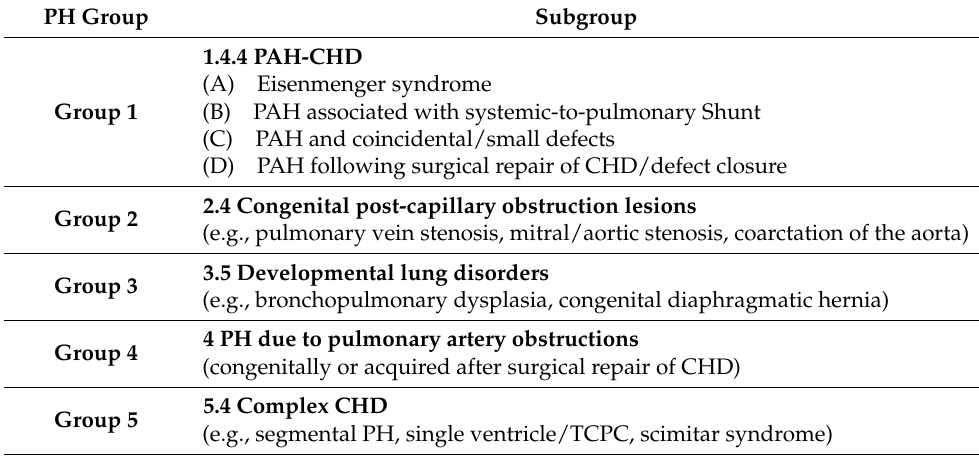
Table 2. Clinical classification of pulmonary arterial hypertension/pulmonary hypertension associ- ated with congenital heart disease (modified from Simmoneau et al.